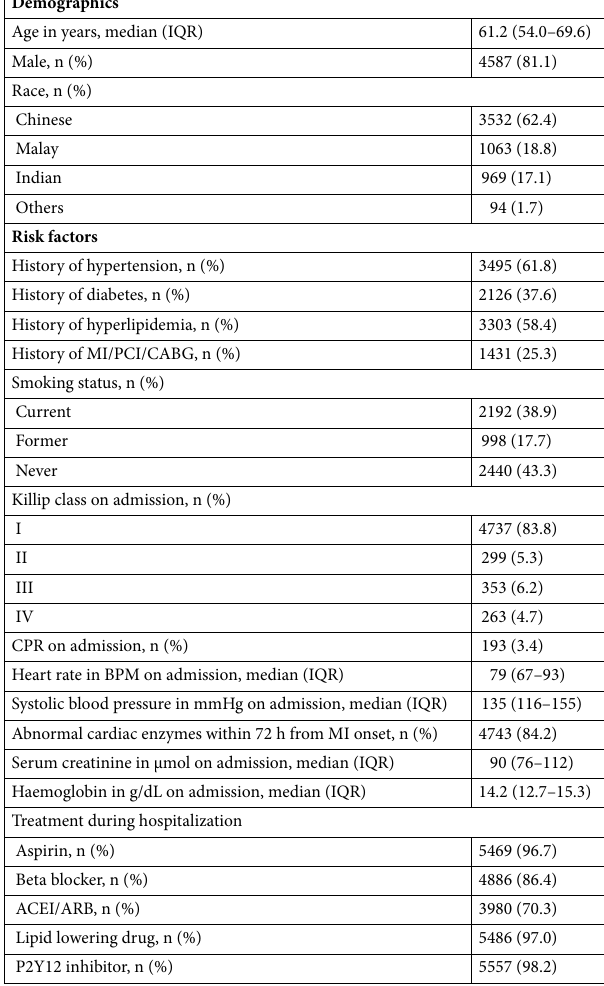
Table 1. Baseline characteristics of all acute myocardial infarction patients included in this study (n = 5658). ACEI/ARB angiotensin-receptor converting enzyme inhibitor/angiotensin receptor blocker, BPM